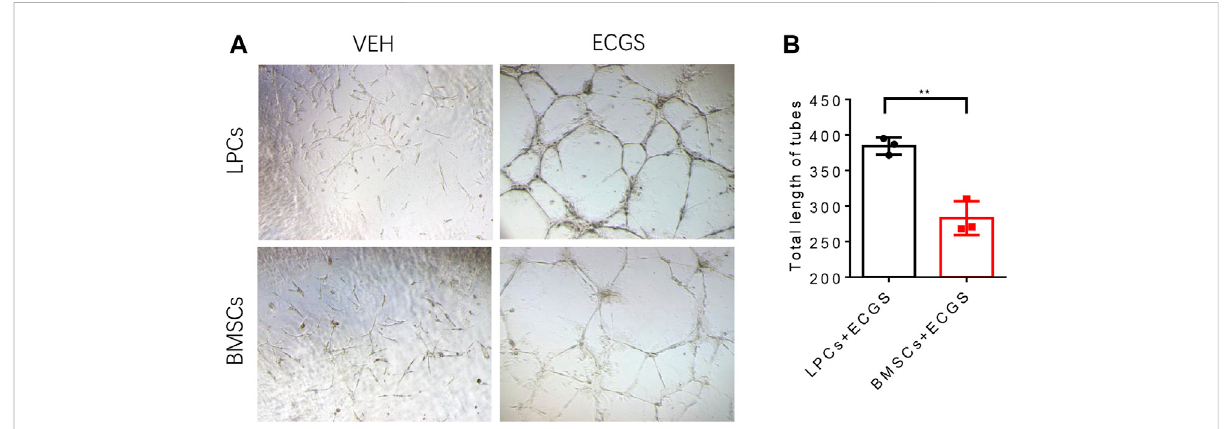
FIGURE 3 The characteristic angiogenic properties of LPCs and BMSCs. (A) Representative microphotographs of capillary-like tubes formed by induced LPCs and BMSCs on Matrigel in the presence of ECGS or vehicle media. (B) Quantitative analysis of the total length of tubes structure in the ECGS or vehicle treated groups (Pixels). ** p =